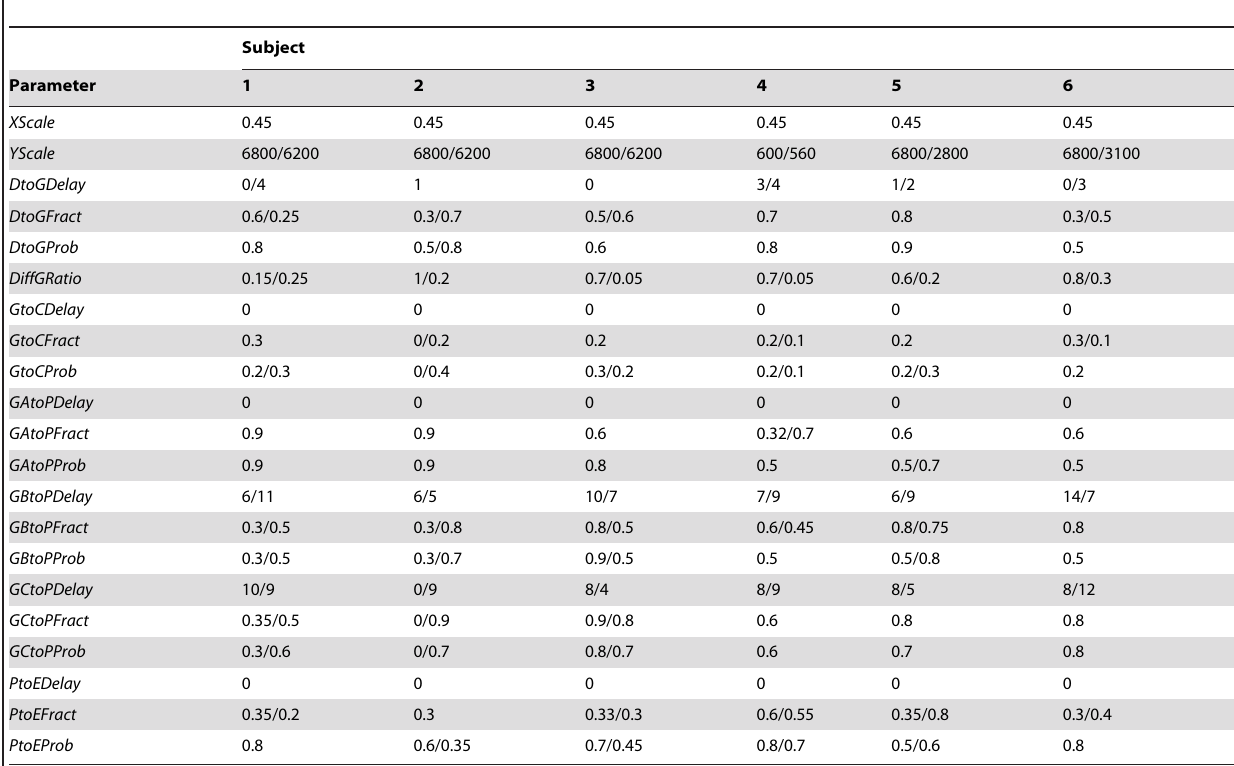
Table 2. Subject-specific parameter values used for validation